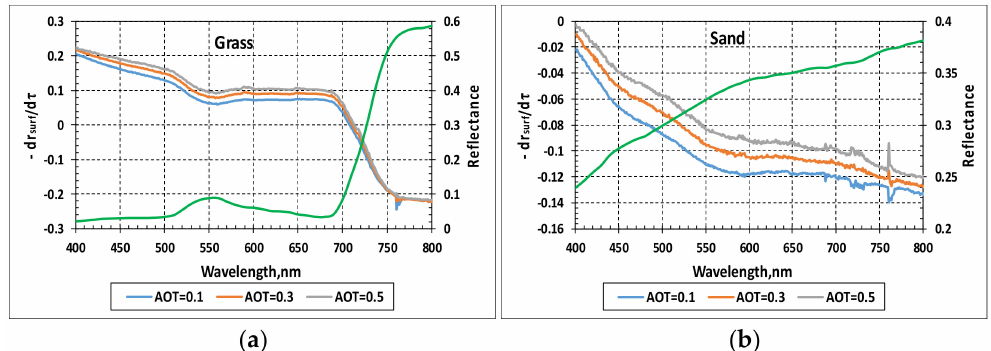
Figure 3. Reflectance spectra (green line) and derivative dr surf / d τ aer for grass ( a ) and sand ( b ) at various values of